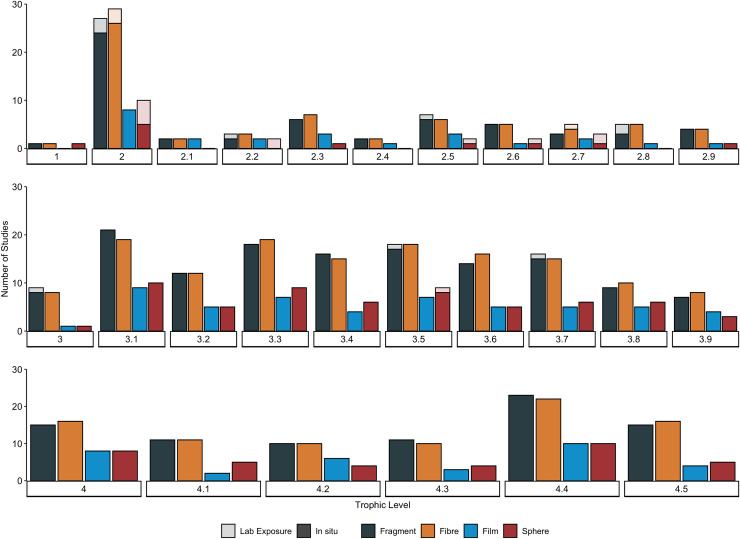
Frequency of microplastic (MP) shapes reported in studies on marine species collected in situ and exposed in laboratory experiments.Data has been organised by trophic level, which are grouped into to a single decimal place, i.e. level 4.2 includes 4.21 to 4.29. Microplastic shapes include those found in organisms collected from field samples (n = 87 studies; dark shaded on bottom) or used in laboratory experiments investigating MP uptake, including those focused on trophic transfer (n = 22 studies; light shaded on top). Details regarding the number and percentage of studies for each level have been provided in S8 Table in S1 File.